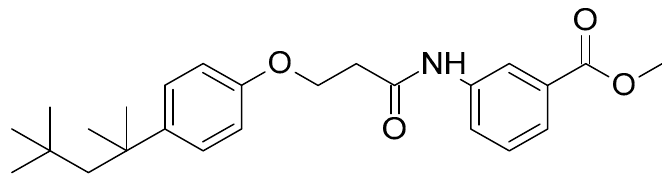
Figure 1. Chemical structure of AC1497.